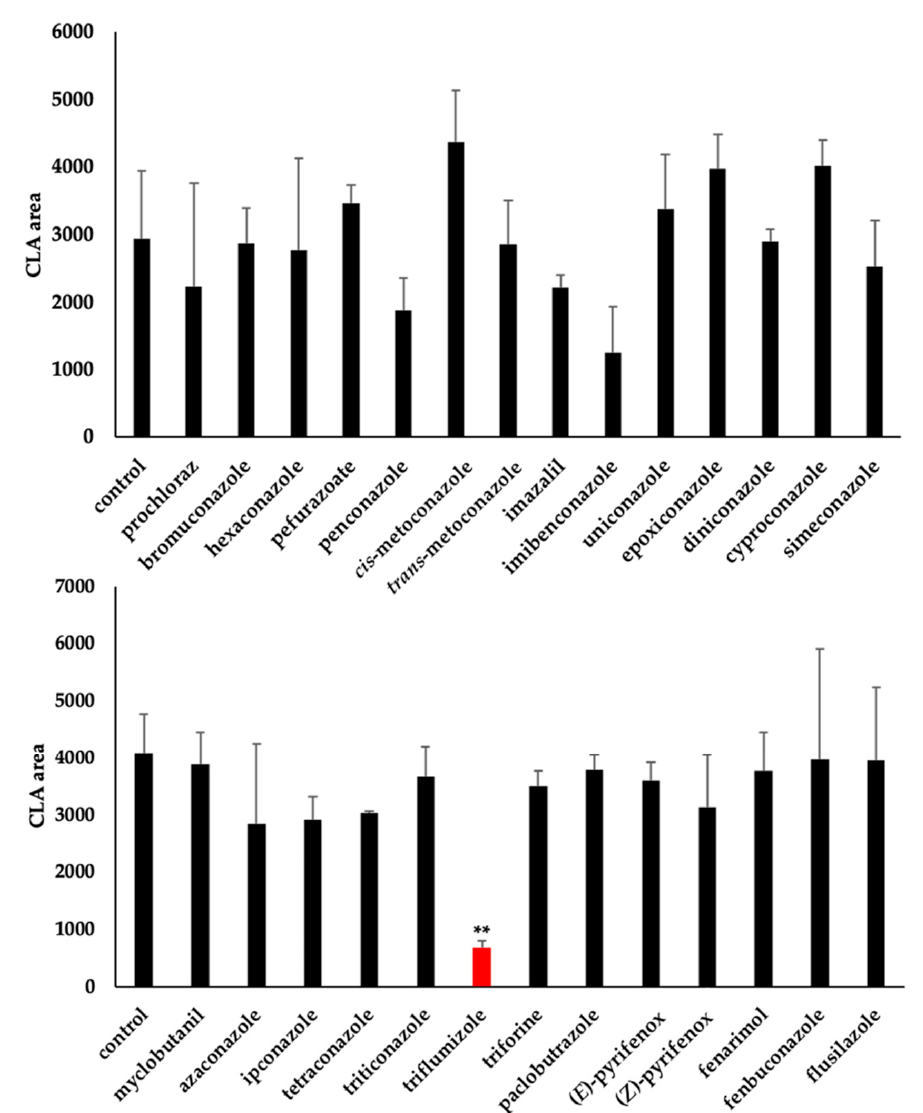
Figure 3. Effect of screening compounds on Os900 in vitro. CLA levels following the addition of 10 μ M of each compound to microsomal proteins, including Os900. CLA levels were determined by LC-MS/MS. Red bar represents the compound which showed the lowest CLA area. The data are presented as mean ± SD ( n = 3). ** denotes statistically significant difference from the CLA level in the no-application of chemicals (control) ( t test; p < 0.01).